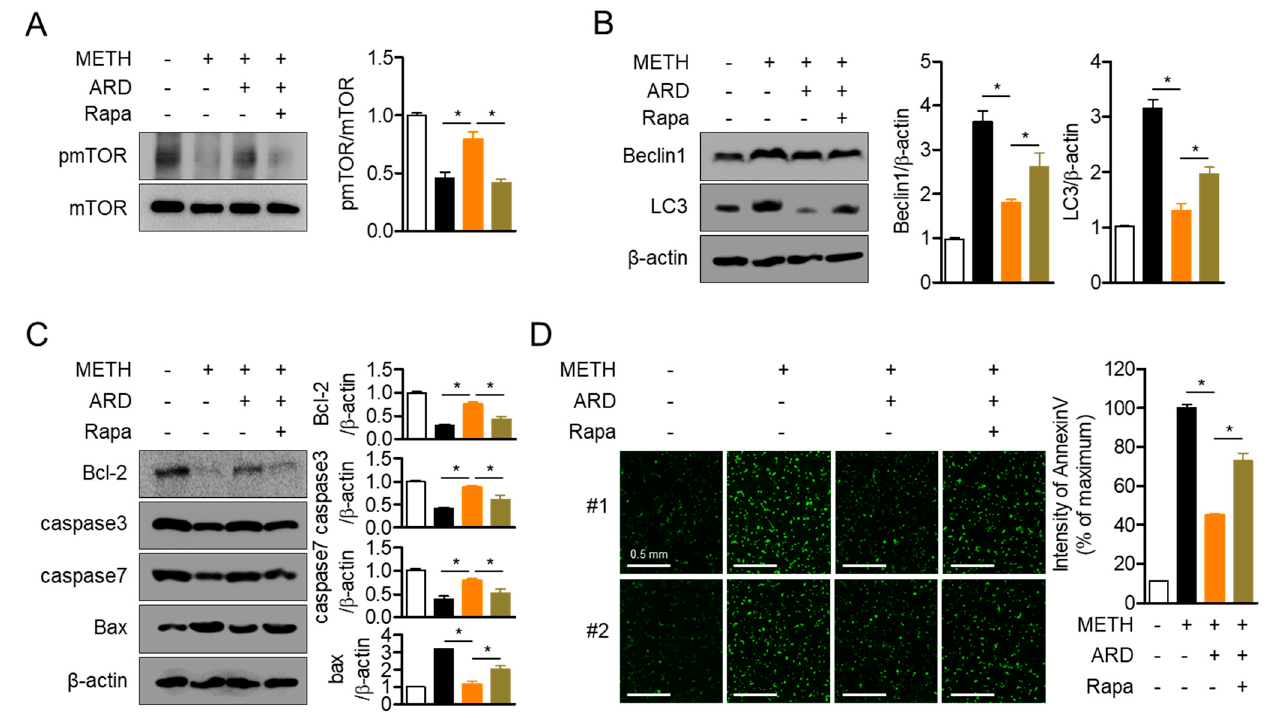
Figure 9. ( A ) SH-SY5y cells (1 × 10 5 /well, 6-well plate) were pre-treated with 50 μ M rapamycin for 1 h and then 40 μ M of aromadendrin for 1 h. Cells exposed to 2 mM METH for 30 min were harvested for Western blotting analysis. The phosphorylation level of mTOR was detected and normalized with the total level of mTOR. ( B , C ) SH-SY5y cells (1 × 10 5 /well, 6-well plate) were pre-treated with 50 μ M rapamycin for 1 h and then 40 μ M of aromadendrin for 1 h. Cells were incubated with 2 mM METH for 24 h and collected for Western blotting analysis. The level of indicated proteins was measured by Western blotting analysis and normalized with the level of β -actin. ( D ) SH-SY5y cells (5 × 10 3 /well, 96-well plate) stained with 1 × AnnexinV staining reagent were pre-treated with 50 μ M rapamycin for 1 h and then pre-treated with 40 μ M aromadendrin for 1 h. Cells were exposed to 2 mM METH for 24 h, and the expression of AnnexinV was detected using the IncuCyte ® imaging system. The intensity of AnnexinV was calculated by IncuCyte ® imaging system software. White bar indicates 0.5 mm. The mean value of three experiments ± SEM is presented. * p < 0.05 between the two indicated groups.